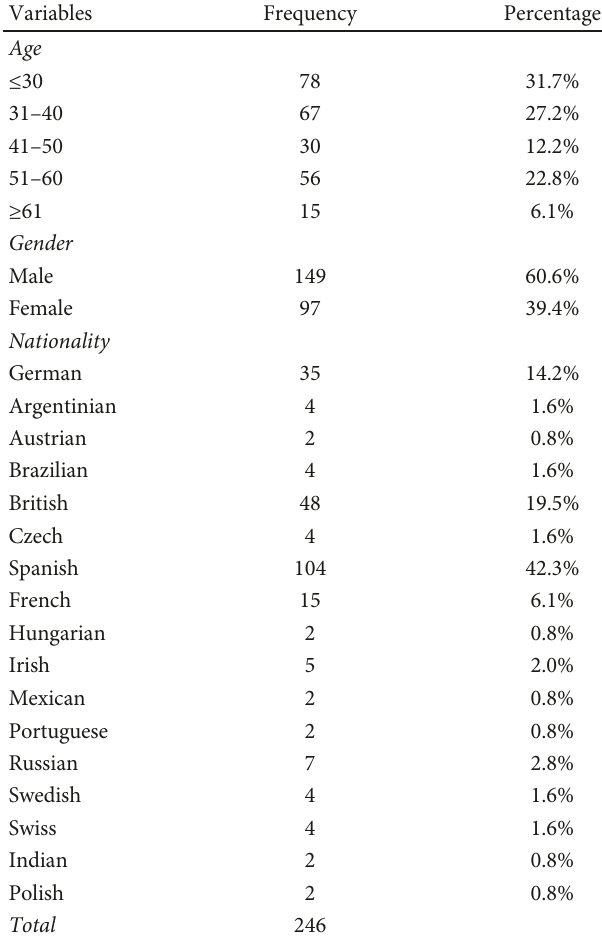
Table 1: Demographic pro fi le of the